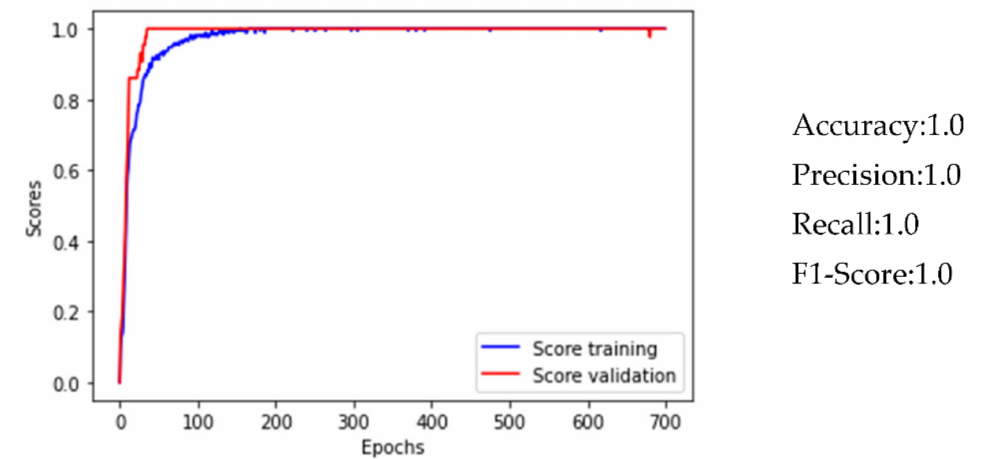
Figure 15. Application of the ANN method with flow and pressure